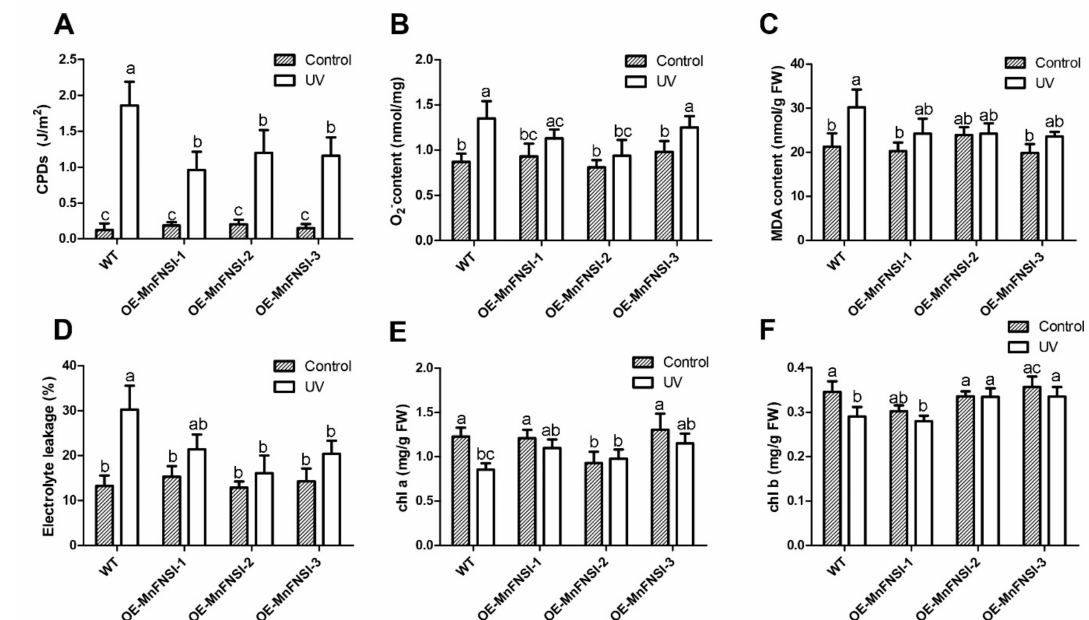
Figure 5. UV-B tolerance analyses of MnFNSI transgenic tobacco plants. Analysis of DNA damage, superoxide accumulation, lipid peroxidation, membrane injury, and chlorophyll content in wild-type and transgenic tobacco overexpressing MnFNI after the UV-B treatment. ( A ) CPDs levels. ( B ) O 2 − content. ( C ) MDA content. ( D ) Electrolyte leakage. ( E , F ) chlorophyll content (Chl a and Chl b).